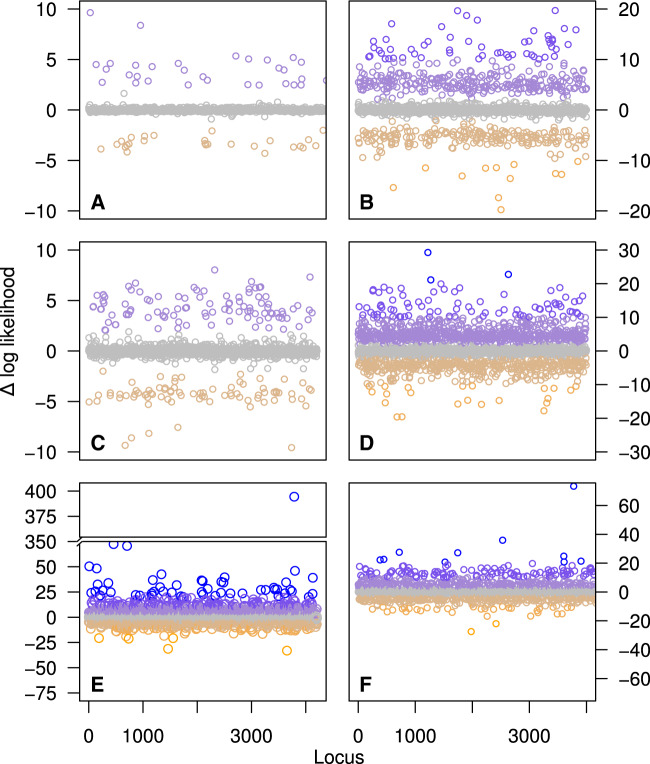
Likelihood plots showing Δ locus-wise log-likelihood (Δ l-lk) for topologies estimated with and without missing data for the Low Coverage data set. The y axis is the Δ l-lk and the x axis represents individual loci across the full alignment. Shown are the results for six subclades assessed within Loriini using the Low Coverage data set: (A) Parvipsitta and Psitteuteles, (B) Chalcopsitta and Pseudeos, (C) Neopsittacus, (D) Charmosyna, Vini, and Phigys, (E) Eos, Trichoglossus, Glossopsitta concinna, and Psitteuteles iris, and (F) Lorius. Points are colored according to the magnitude of the Δ l-lk scores according to a gradient ranging from >20 (blue) through <−10 (orange).